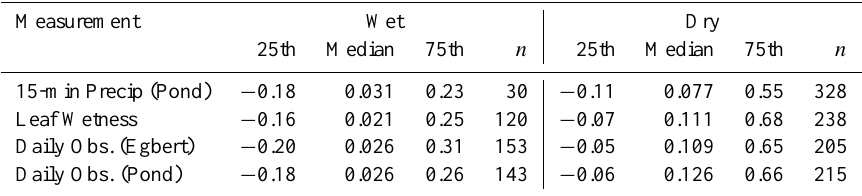
Table 1. Quartiles of 62nm bin fluxes [10 6 m − 2 s − 1 ] and number of observations, n , for wet and dry conditions as determined by various measurement